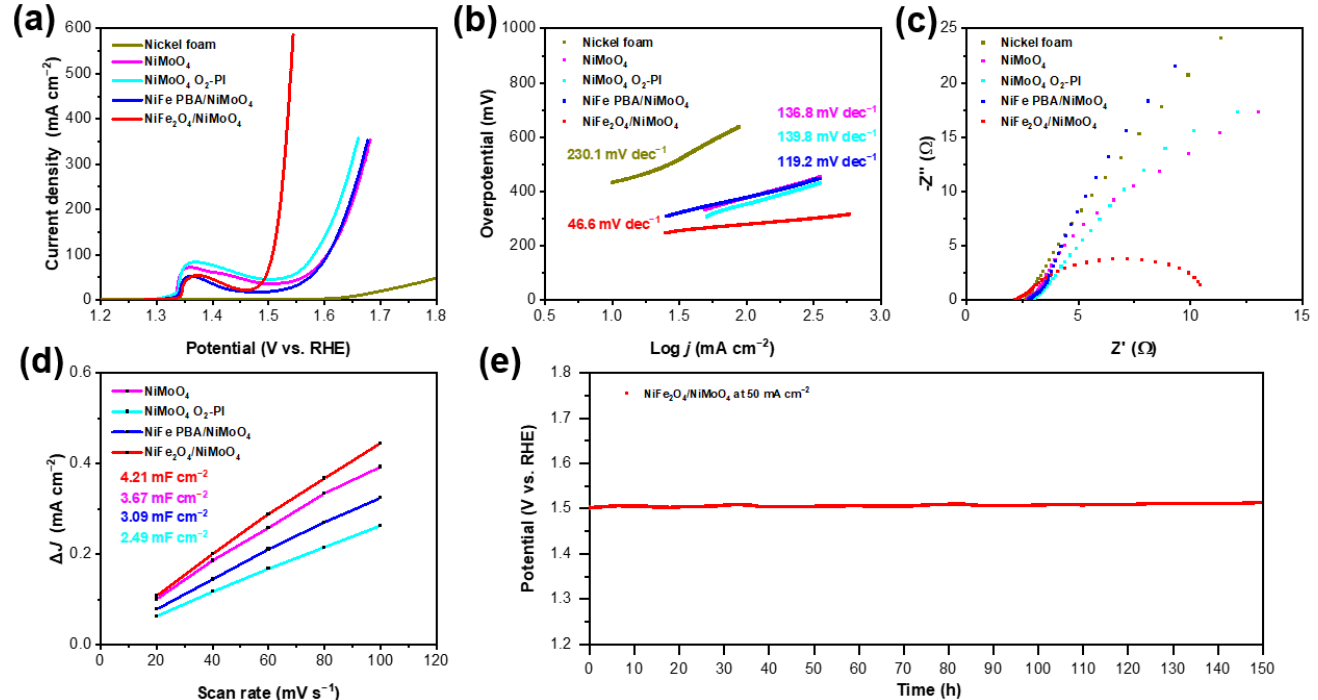
Figure 4. ( a ) Polarization curves and ( b ) corresponding Tafel slope plots of as-prepared catalysts; ( c ) EIS Nyquist plots of NiMoO 4 , NiMoO 4 O 2 -Pl, NiFe PBA/NiMoO 4 , and NiFe 2 O 4 /NiMoO 4 ; ( d ) capacitive current densities plotted as a function of the scan rate; and ( e ) chronopotentiometry of NiFe 2 O 4 /NiMoO 4 at 50 mA cm −2 with iR corrected.